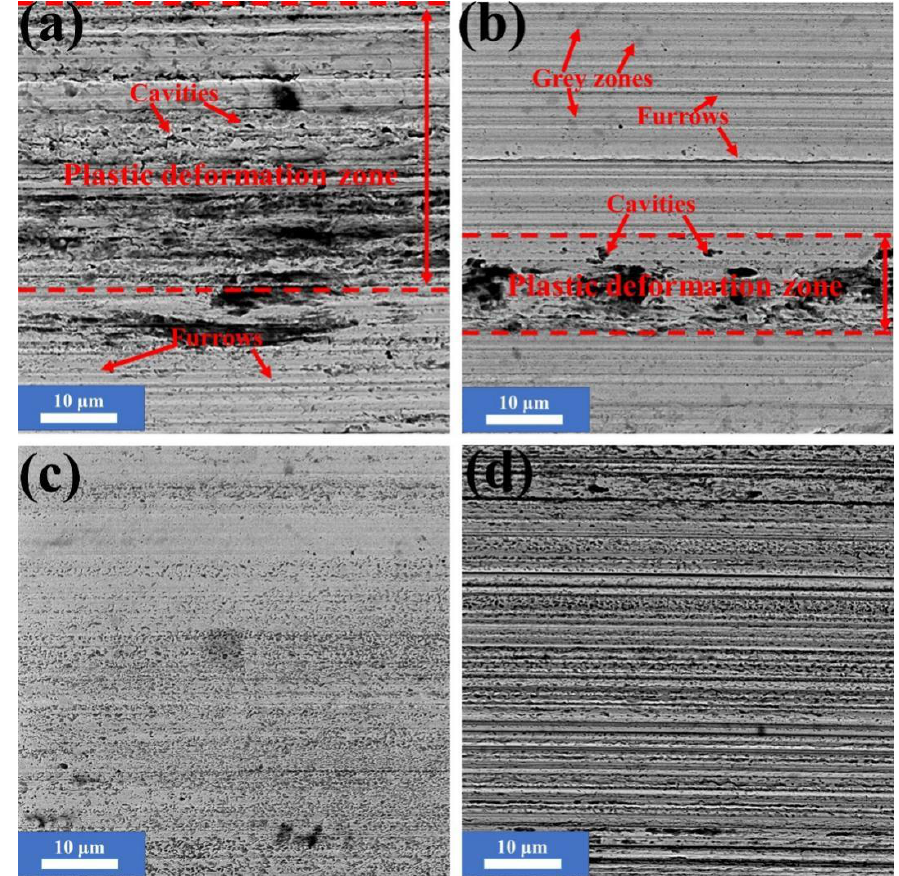
Figure 3. SEM images of worn surfaces under the lubrication of pure liquid paraffin (LP; a ), LP + 0.1 wt % nanoscaled serpentine powders (NSPs; b ), LP + 0.5 wt % NSPs ( c ), and LP + 1.0 wt % NSPs ( d ). Table 2. The element content (atomic concentration) of the worn surfaces in Figure 3.